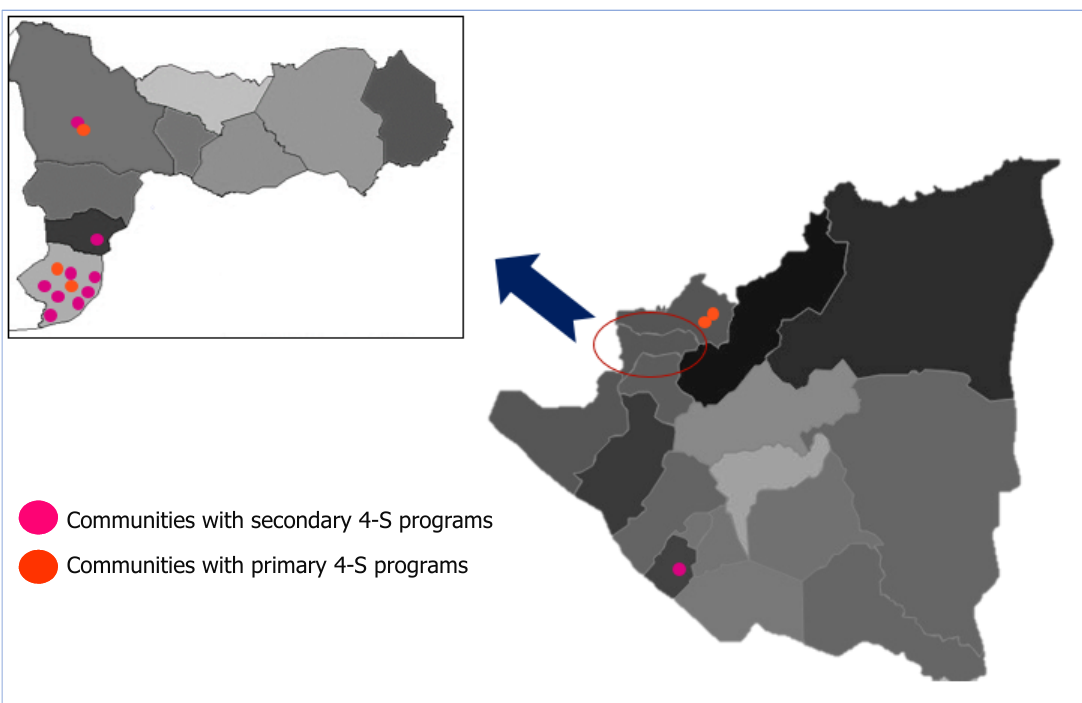
Figure 1. 4-S Clubs in Nicaragua, July